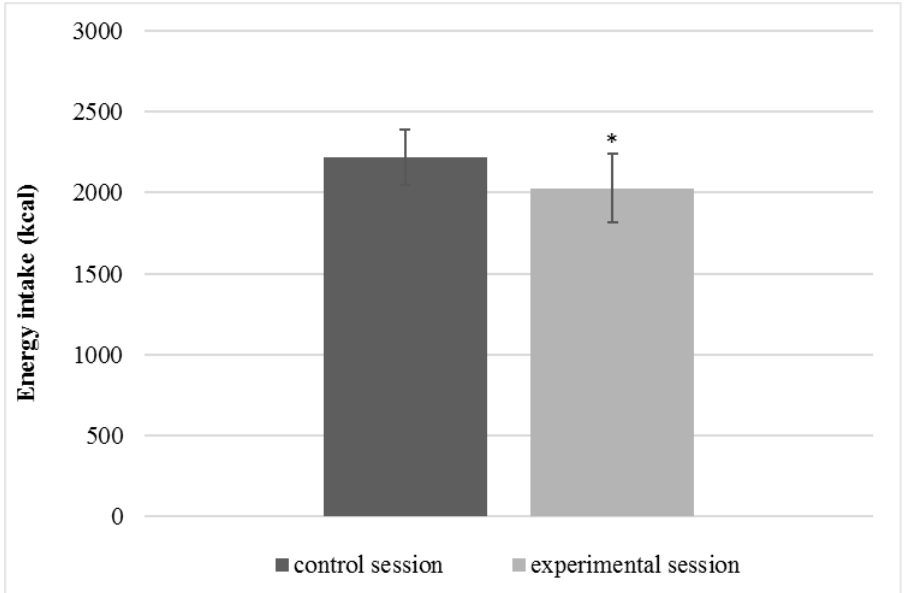
Figure 6. Rating of energy intake in the control and experimental session. Values are mean±SD (n=10). * = Significant difference between two sessions using the T-test